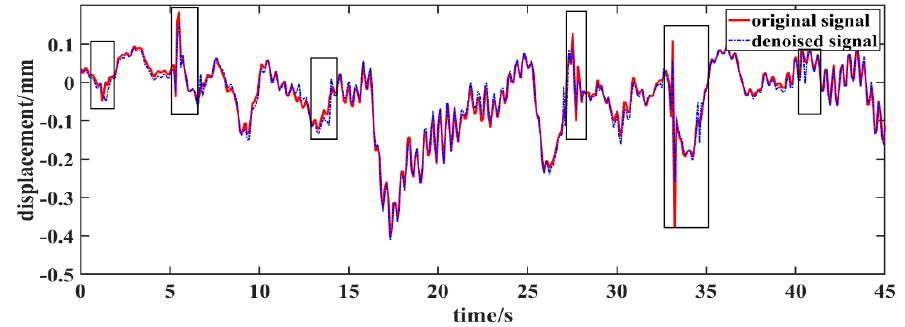
Figure 11. De-noised time-series displacement of the mid-span point of the Fengbei Bridge.